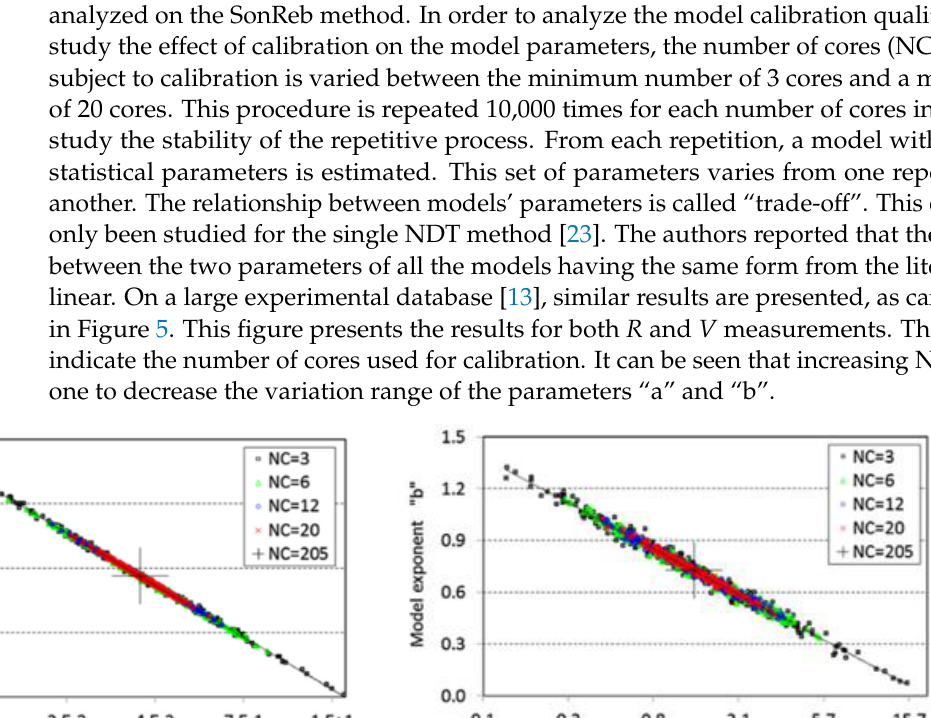
Figure 4. Fitting and prediction errors (FEC and PEC) as a function of NC resulting from analyzing the in situ dataset S1 [40].